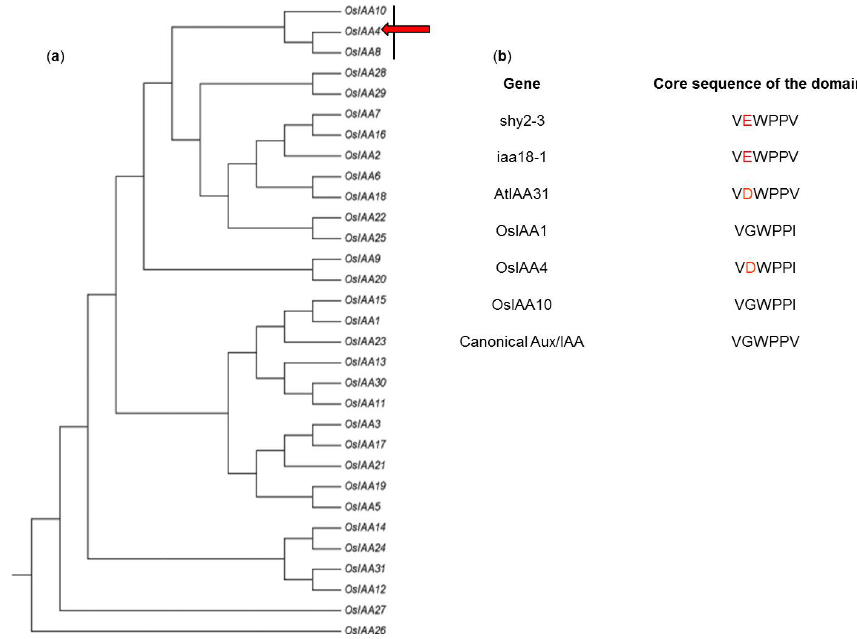
Figure 1. Identification of OsIAA4. ( a ) Phylogenetic tree of rice AUXIN/INDOLE-3- ACETIC ACID (Aux/IAA) proteins. Red arrow indicates position of OsIAA4 in the phylogenetic tree; ( b ) Domain II of different Aux/IAA proteins. Red letters indicate differences in domain II between dominant mutants (shy2-3 and iaa18-1) or non-canonical Aux/IAA (AtIAA31 and OsIAA4) and canonical Aux/IAA